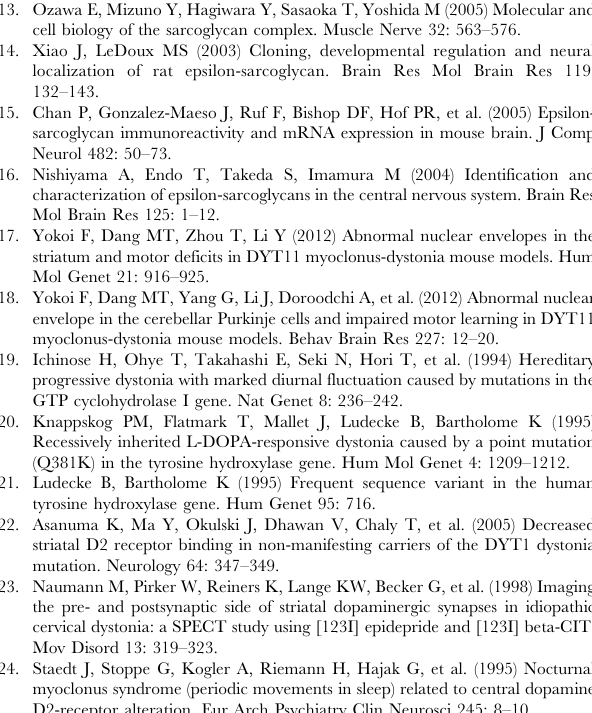
Figure S1 RT-PCR analysis of striatal D2R. Semiquanti- tative RT-PCR analysis of RNA samples extracted from striatum of sgce KO and their WT littermates, b -actin was used as control in this test. The quantified results are shown in the right side. The vertical bars represent means 6 SEM of 2 pairs of